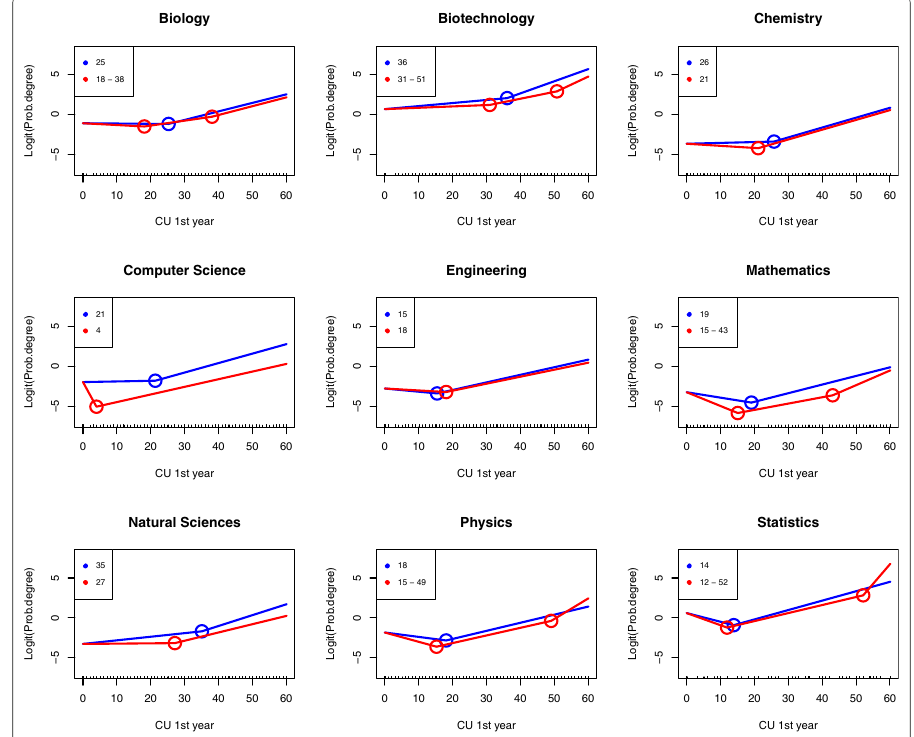
Fig. 4 Segmented relationships between the logit of the probability of success and the CU earned at the end of the first year of the marginal models in Eq. (5) by degree course. Cohort of freshmen enrolled in